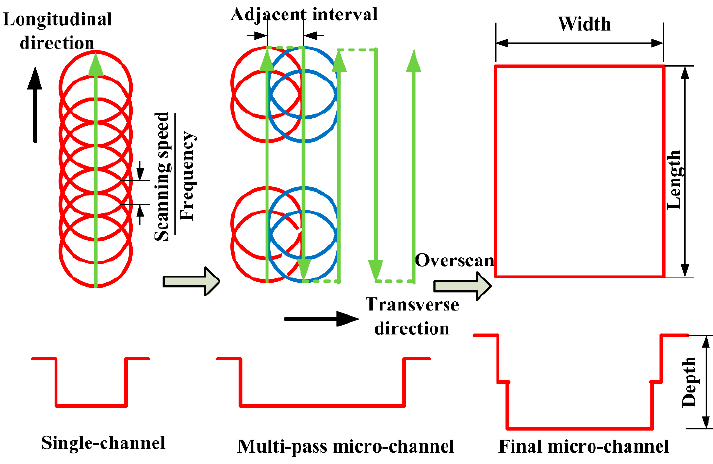
Figure 1. Schematics for the formation of micro-channel.